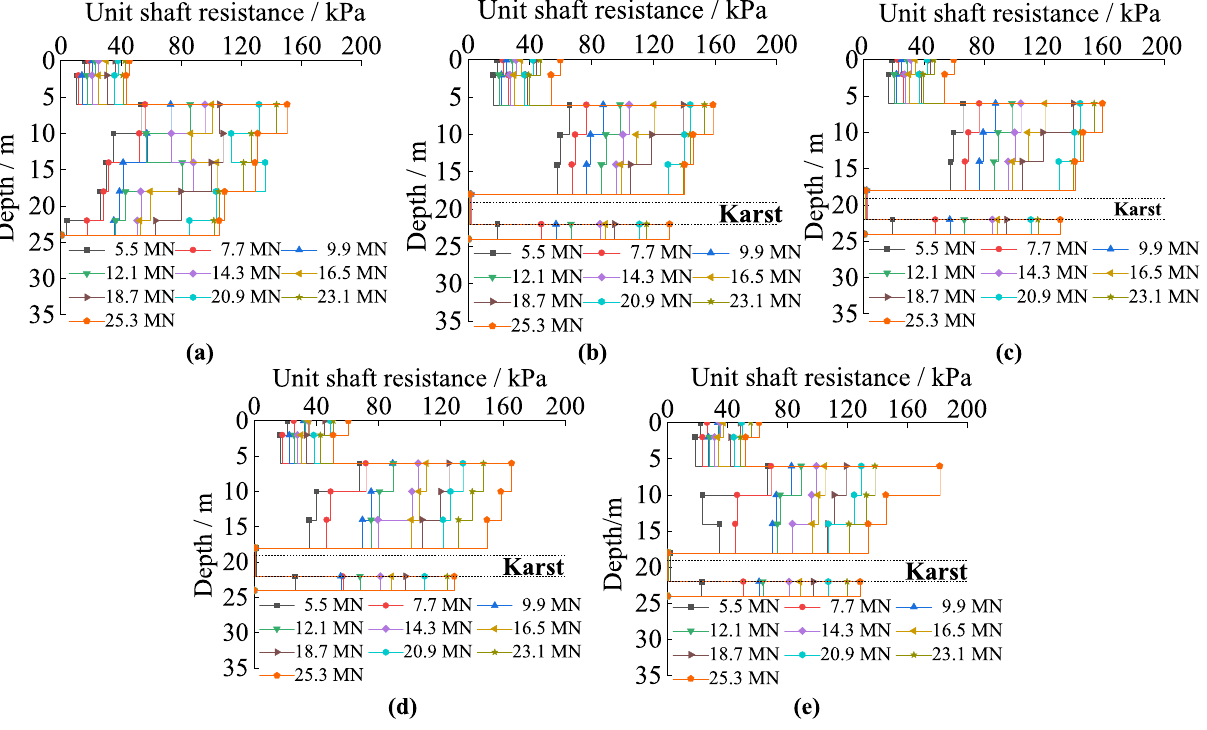
Figure 7. The unit shaft resistance of piles with different karst cave span: ( a ) no cave; ( b ) cave’s span is 3 m × 3 m; ( c ) cave’s span is 6 m × 6 m; ( d ) cave’s span is 9 m × 9 m; ( e ) cave’s span is 12 m × 12 m.